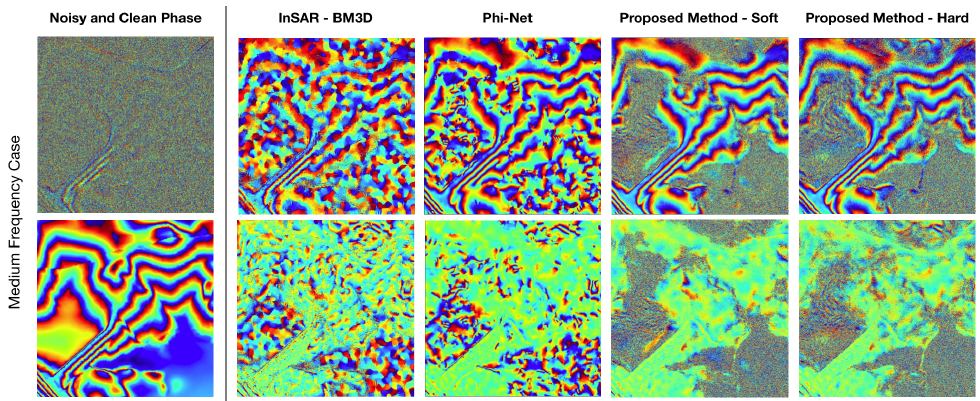
Figure 10. Filtered interferometric phase ( top ) and corresponding residues ( bottom ) of the three compared methods tested on medium-frequency synthetic